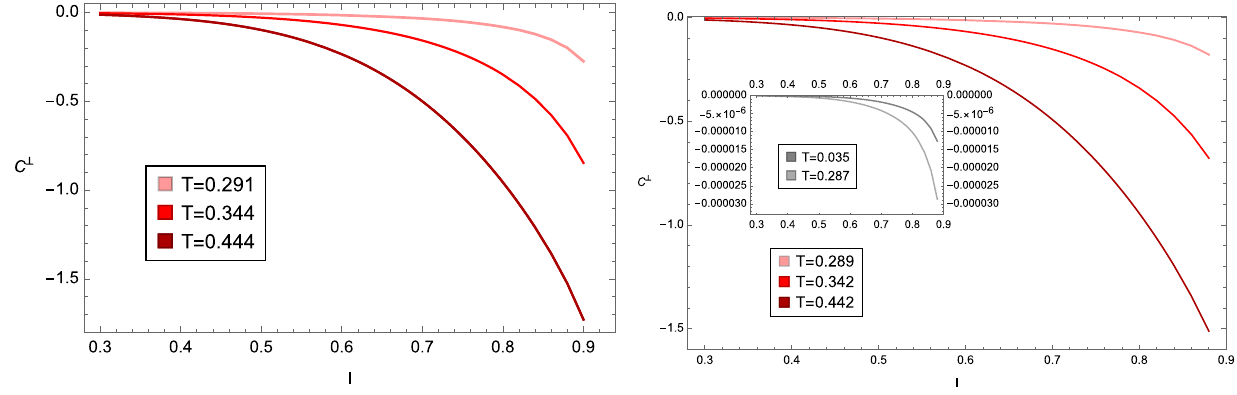
Fig. 11 Left: C ⊥ as a function of l at ν = 2 and μ = 0 for temperatures above and near T HP ≈ 0 . 290. Right: C ⊥ as a function of l at ν = 2 for μ = 0 . 05 and different values of temperature below and above the phase transition temperature, T